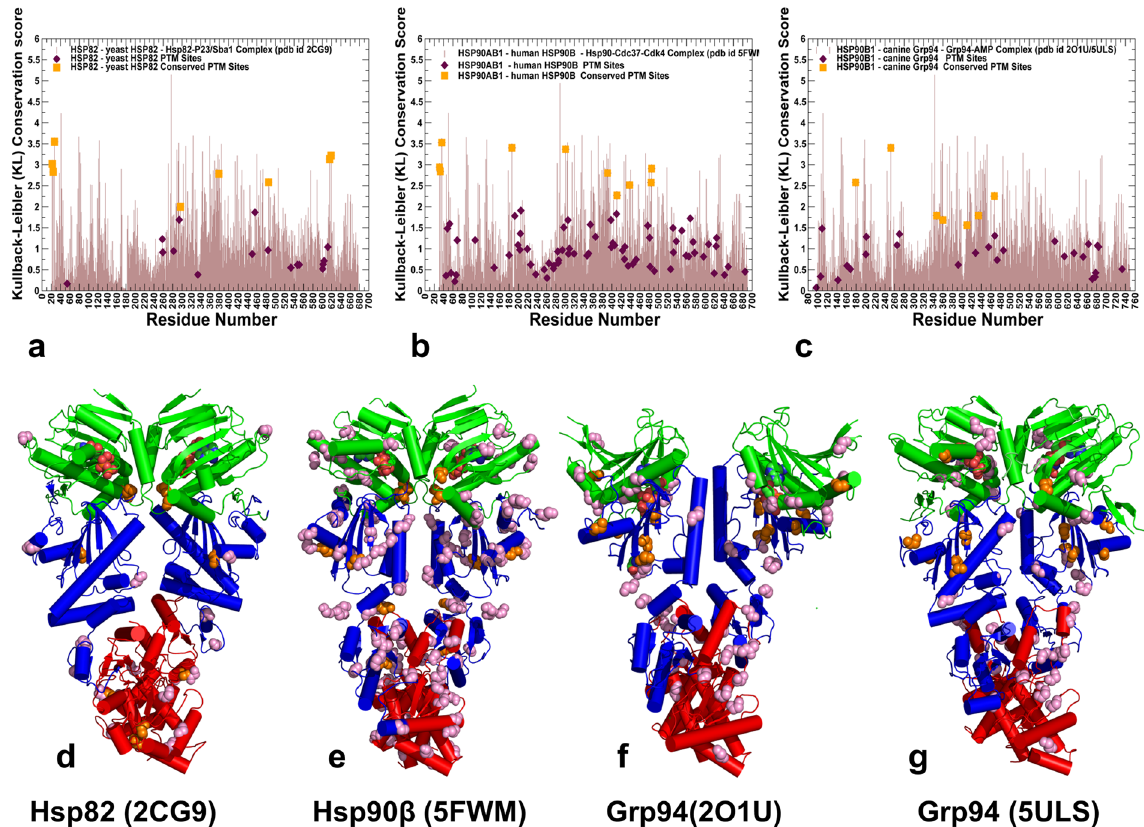
Figure 1. Evolutionary Analysis and Structural Organization of the Hsp90 Proteins. The KL conservation score of the Hsp90 proteins was calculated using MSA profiles of the HATPase_c family (PF02518), corresponding to the Hsp90-NTD residues and the Hsp90 family (PF00183) that corresponds to the Hsp90-MD and CTD domains. The KL score is mapped onto the Hsp90 residues in the structures of ATP-bound yeast Hsp82 ( a ), human Hsp90 β in the Hsp90-Cdc37-Cdk4 complex ( b ), and ATP-bound forms of canine Grp94 ( c ). The KL conservation profiles are shown in brown bars, the position of experimentally known PTM sites are annotated as filled maroon diamonds, and the conserved PTM sites are shown as filled orange squares. ( d ) The crystal structure of ATP-bound yeast Hsp82 (pdb id 2CG9) is shown in a ribbon representation and the domains are colored as follows: Hsp90-NTD (residues 2–216, in green), Hsp90-MD (residues 217–526, in blue) and Hsp90- CTD (residues 527–677, in red). ( e ) The cryo-EM structure of the human Hsp90 β in the